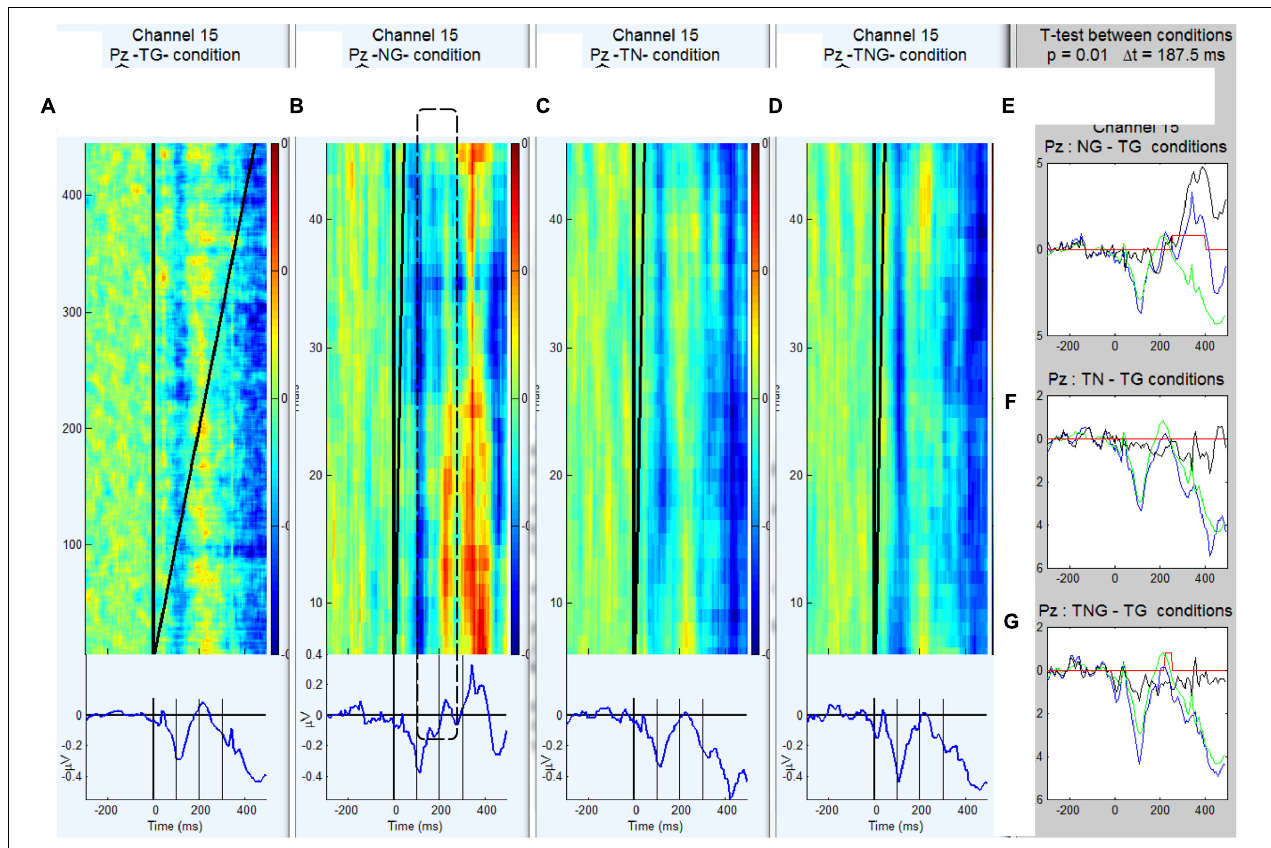
FIGURE 3 | (A–D) Grand average ERP waveforms and trial by trial voltage plots at Pz electrode in 20 control participants in the standard goal (TG), novel preceding goal (NG), novel target (TN) and simultaneous novel and goal (TNG) conditions. (E–G) Waveforms generated by subtraction (in black) of novel conditions from control condition (TG in green) and corresponding t -values for successive time bins of 187.5